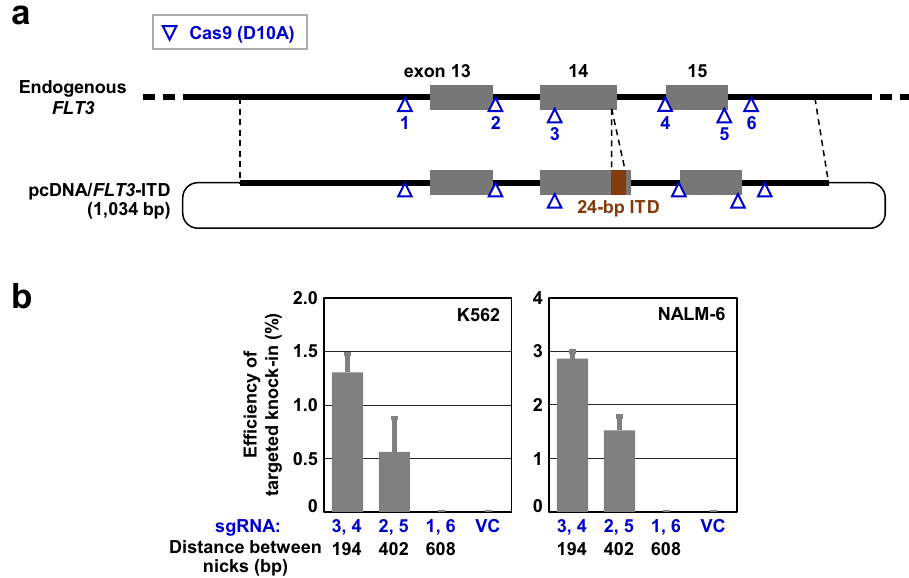
Figure 4. An FLT3 -based assay providing further evidence that locating two nicks close together facilitates TPN-based targeted knock-in. (a) Experimental setup of targeted knock-in of an FLT3 -ITD. The length of a homologous region in the donor plasmid (pcDNA/FLT3-ITD) is noted in parenthesis. ITD, internal tandem duplication. (b) The efficiencies of targeted knock-in of the 24-bp ITD in the K562 (left) and NALM-6 (right) cell lines determined by IDAA assays. IDAA, indel detection by amplicon analysis. Data represent mean and SEM values from three independent